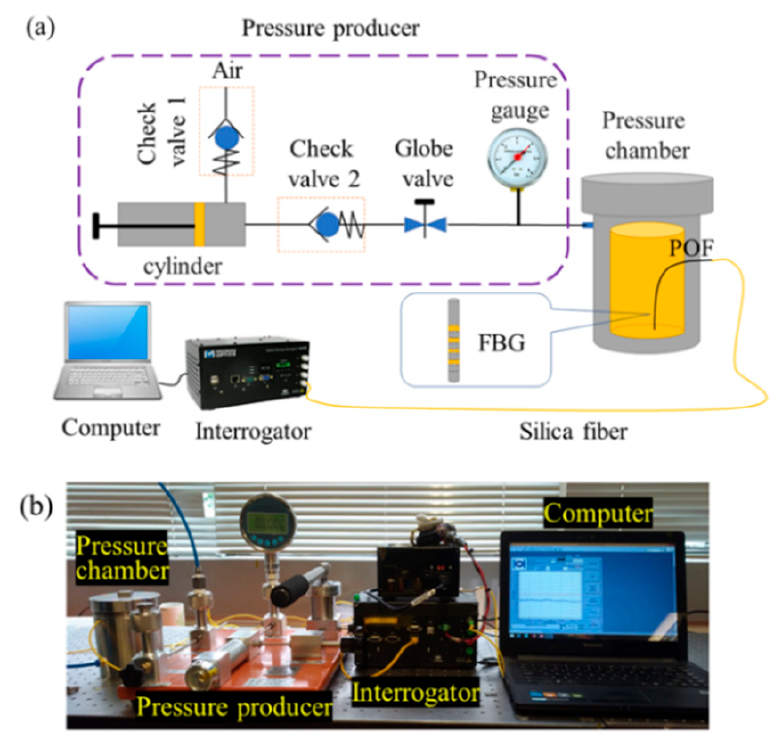
Figure 3. ( a ) The schematic diagram and ( b ) the experimental photo of the gas pressure calibration system.